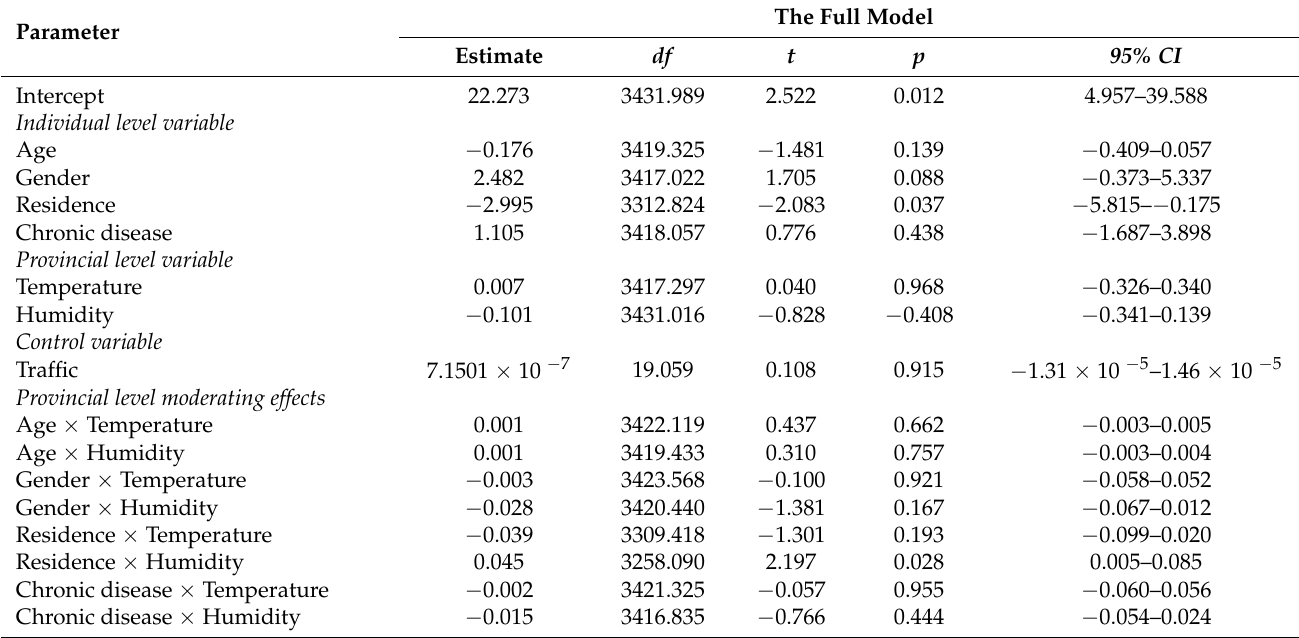
Table 5. The effects of individual level and provincial level variables in the full model.